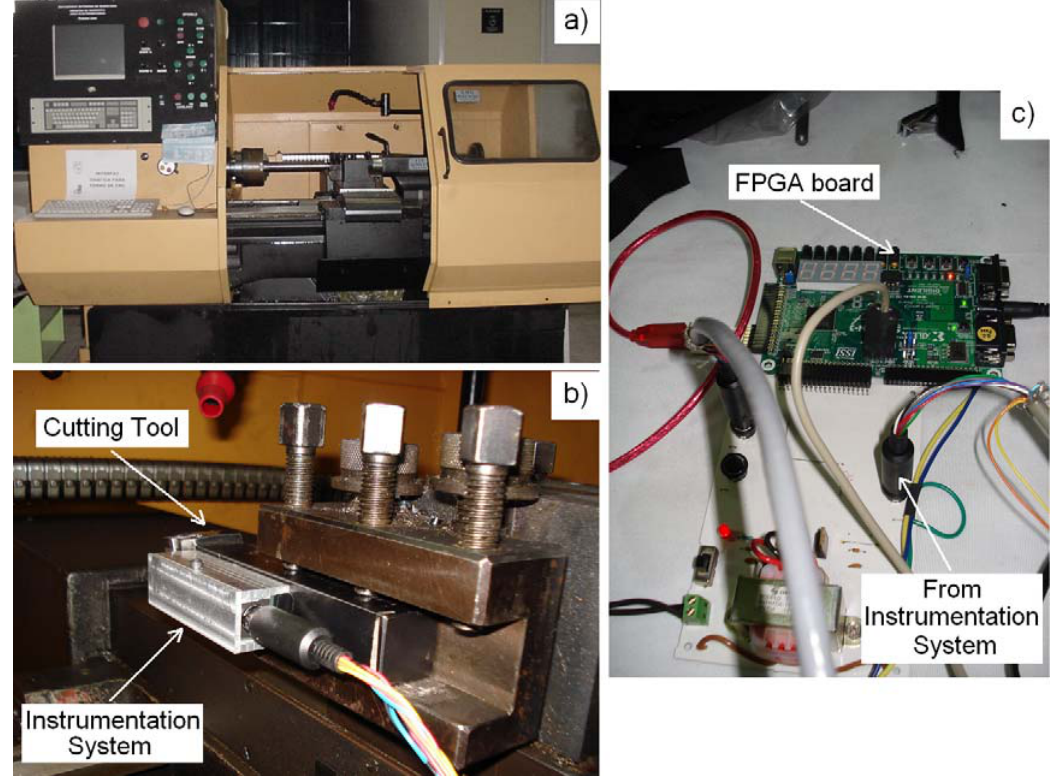
Figure 11. Experiment setup. (a) Retrofitted CNC lathe. (b) Instrumentation system mounting. (c) FPGA-based signal processing